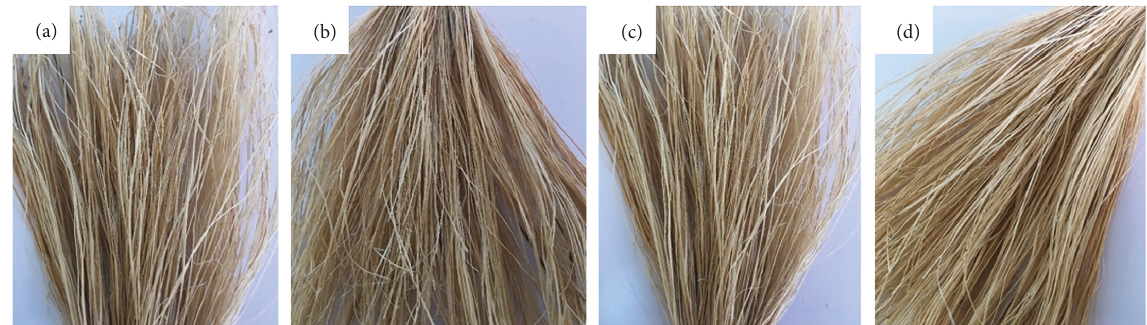
Figure 2: Image of a banana fiber extracted from the banana stem, treated with NaoH solution at different concentrations: (a) -NaoH 1%, (b) -NaoH 2%, (c) -NaoH 4%, and (d) -NaoH 5%.